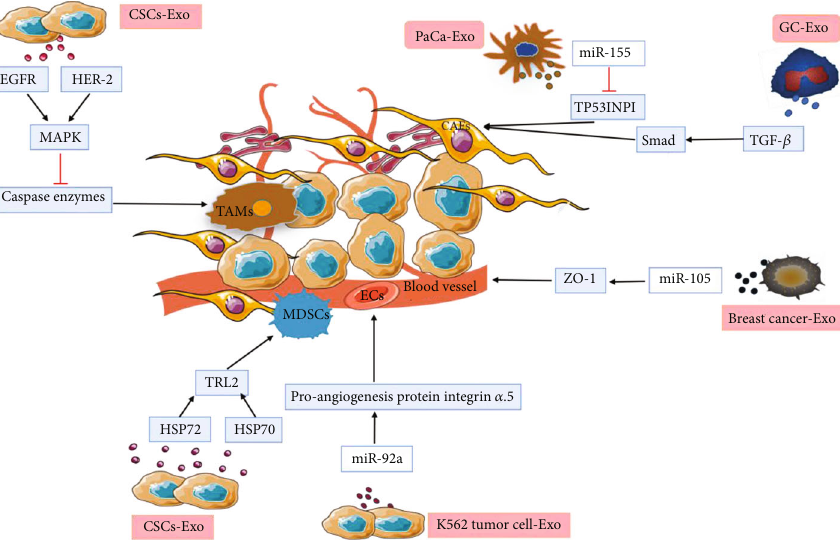
Figure 5: CSC-Exos play a role in the regulation of the tumor microenvironment (TME). Exosomes derived from pancreatic cancer (PaCa) cells are rich of miR-155 and promote the di ff erentiation of fi broblasts into cancer-associated fi broblasts (CAFs) by downregulating the level of TP53INP1 protein in fi broblasts. Proteins carried by CSC-Exos, such as HSP72 and HSP70, target downstream Toll-like receptor 2 (TLR2) to activate myeloid-derived suppressor cells (MDSCs) to promote the formation of the TME. miR-92a loaded in exosomes derived from K562 tumor cells interacts with the proangiogenic protein integrin α 5, causing endothelial cell (EC) migration and primitive vascular lumen formation. Breast cancer-derived exosomes contain miR-105, which downregulates the expression of ZO-1 to increase the permeability of tumor blood vessels in the TME. Gastric cancer cell-derived exosomes (GC-Exos) carry TGF- β , which induces human umbilical cord mesenchymal stem cells (hucMSCs) to di ff erentiate into CAFs through the TGF- β /Smad pathway. Epidermal growth factor receptor (EGFR) and human epidermal growth factor receptor (HER-2) riched in CSC-Exos activate the MAPK signaling pathway of monocytes and inhibit the cleavage of caspases, which contributes to the formation of tumor-associated macrophages (TAMs). Table 1: CSC-Exo-derived RNAs acting as biomarkers in